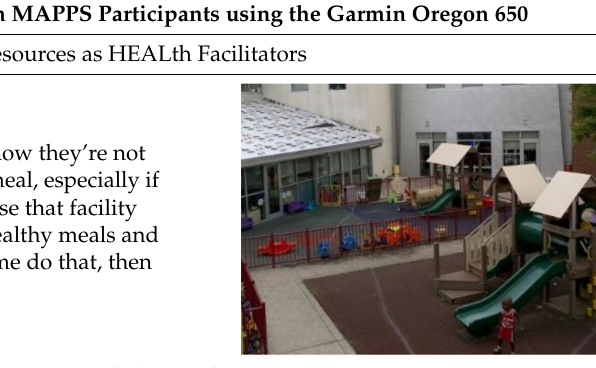
Table 2. HEALth MAPPS TM